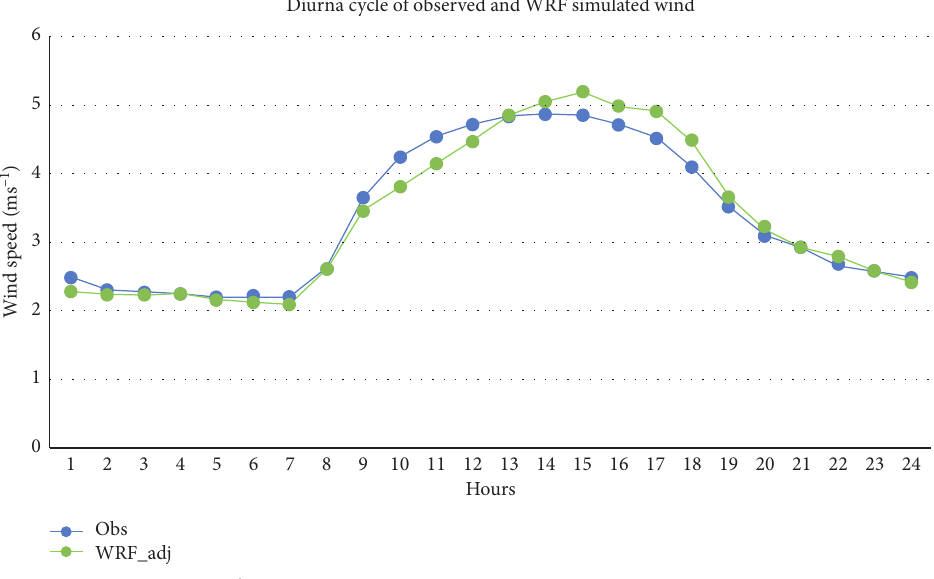
Figure 9: Diurnal cycle of wind speed (m s − 1 ) at 20m level at Bac Lieu station for observations (blue) and adjusted simulation (green). The horizontal axis is the time in the